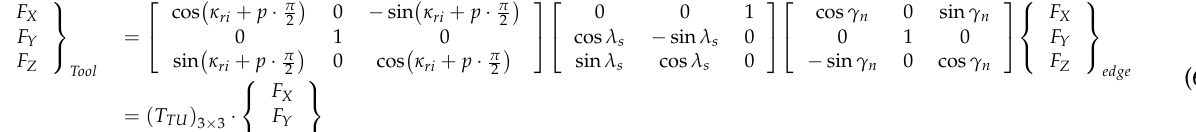
Figure 4. Mechanics of oblique cutting. Step 2, the load is transformed from the cutting edge to tool reference coordinates (X R Y R Z R ) according to the geometry and location of the tool as in Figure